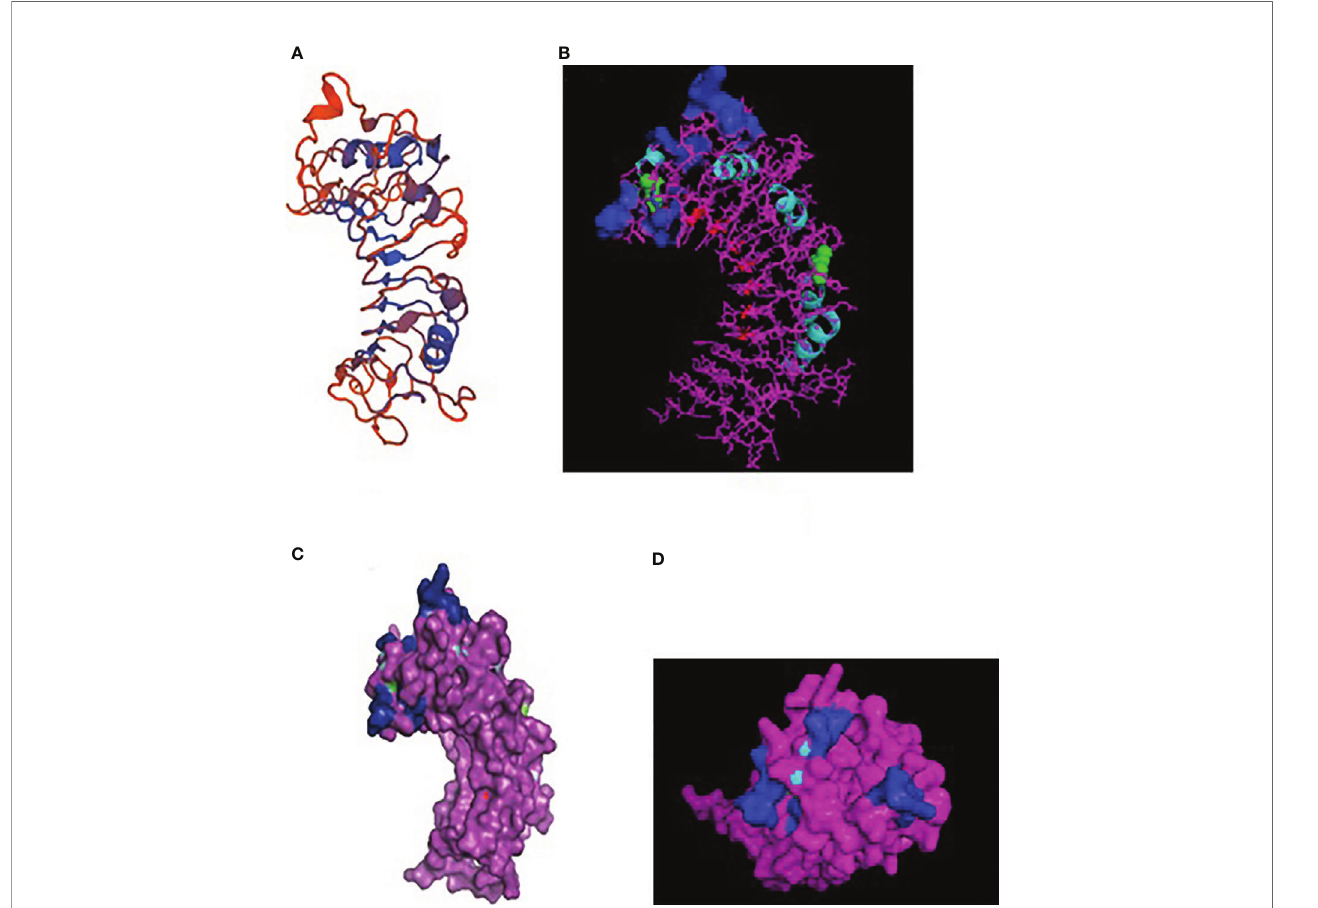
FIGURE 3 | 3D structure of sheep CD14. (A) 3D structure of ovine CD14 gene-Swiss prot view. (B) 3D structure of ovine CD14 gene-Pymol view (with LPS binding sites). (C) 3D structure of ovine CD14 gene-Surface view (with LPS binding sites). (D) Sheep CD14- groove (pathogen binding